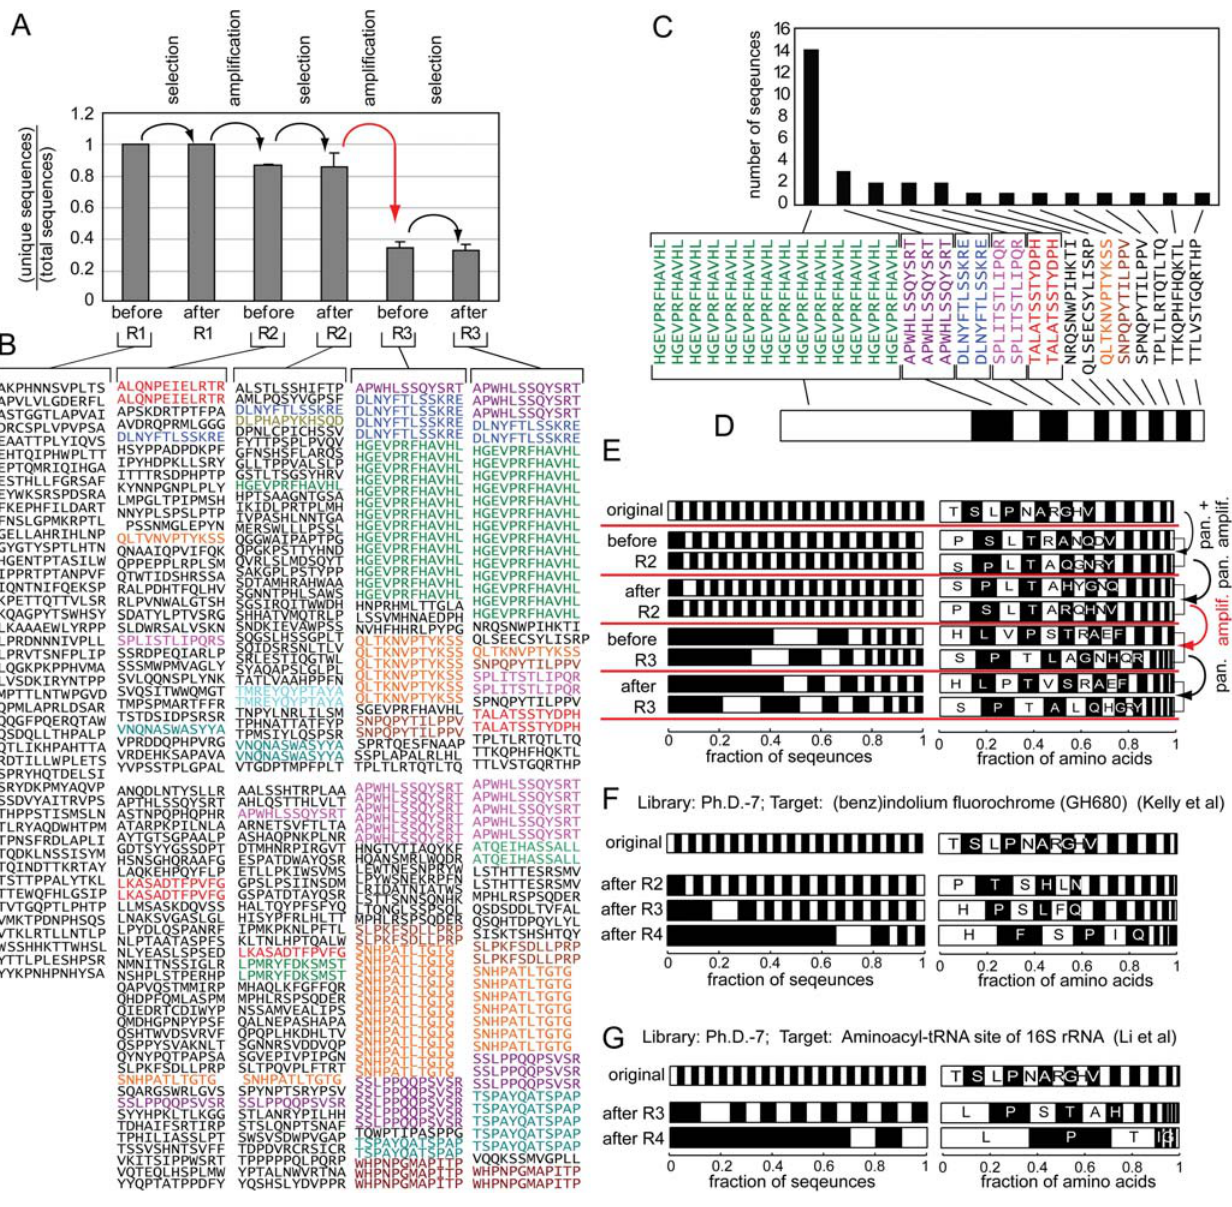
Figure 2. (A) We performed panning starting from the Ph.D.-12 phage library using hES cells as the target. Amplification occurred in a standard shaking culture. After each round of panning or amplification, we sequenced 40-50 clones. The plot in (A) summarizes the results from two independent experiments. The diversity of the library collapses at each amplification step. (B) Sequences from each round; repeating sequences are colored. (C) Distribution of the clones in the library can be presented as a stacked bar chart (D) in which the width of each black or white bar is proportional to the abundance of the peptide sequence. (E) presents the same data as A and B using stacked bars. Two replicates are presented independently. The right set of bars describe the abundance of individual amino acids in the library. (F) describes the sequencing results from Kelly et al. [46], and Li et al. [47]. (A and B are reproduced from Derda et al. [23] with permission). The frequencies of amino acids (AA) in E, G, F (and in subsequent Figures 3 and 4) were calculated as (number of times AA encountered) / (total number of AAs in all